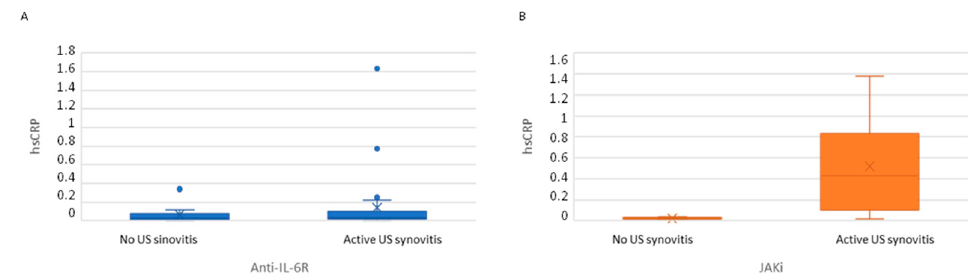
(73%): 30 patients (71%) and 16 patients (76%) in the anti-IL-6R and JAKi groups, respec- trend to higher clinical disease activity in patients with US synovitis, especially PhGA and 28SJC (Table 4). No differences in hsCRP levels were observed in patients with and without a higher hsCRP than those without (Table 4, Figure 1).